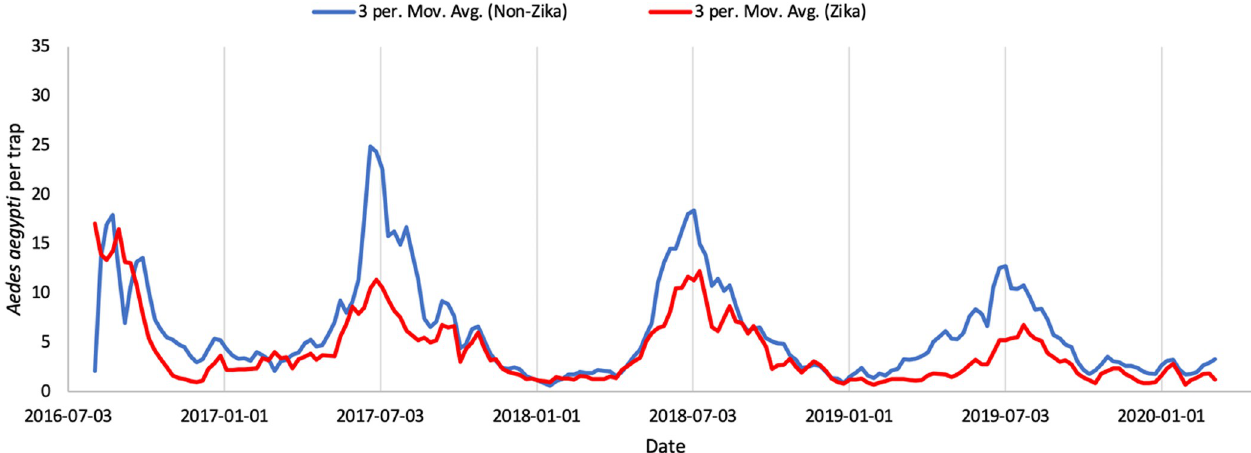
Fig 2. 3-period moving average curve of Ae . aegypti per trap. Conducted for daily average of all traps in areas affected by local Zika transmission during the 2016 outbreak (red) and unaffected areas (blue).